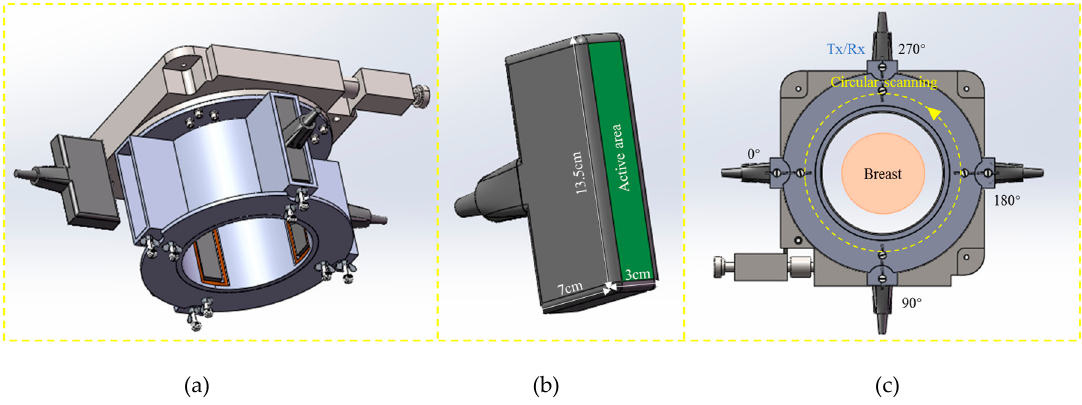
Figure 2. Ultrasound imaging with cylindrical motion of linear arrays. ( a ) Transducer configuration scheme. ( b ) The dimensions of the linear array transducer. ( c ) Cylindrical scanning diagram.